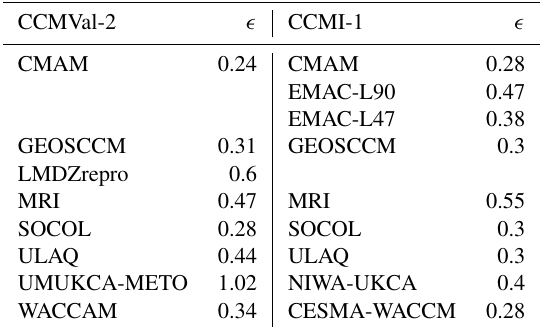
Table 2. Mixing efficiency (cid:15) for all CCMVal-2 REF-B1 (left) and CCMI-1 REF-C1 (right) simulations used in this study. (cid:15) is derived from the TLP model, with the border of the tropical pipe ranging between 20 ◦ N and 20 ◦